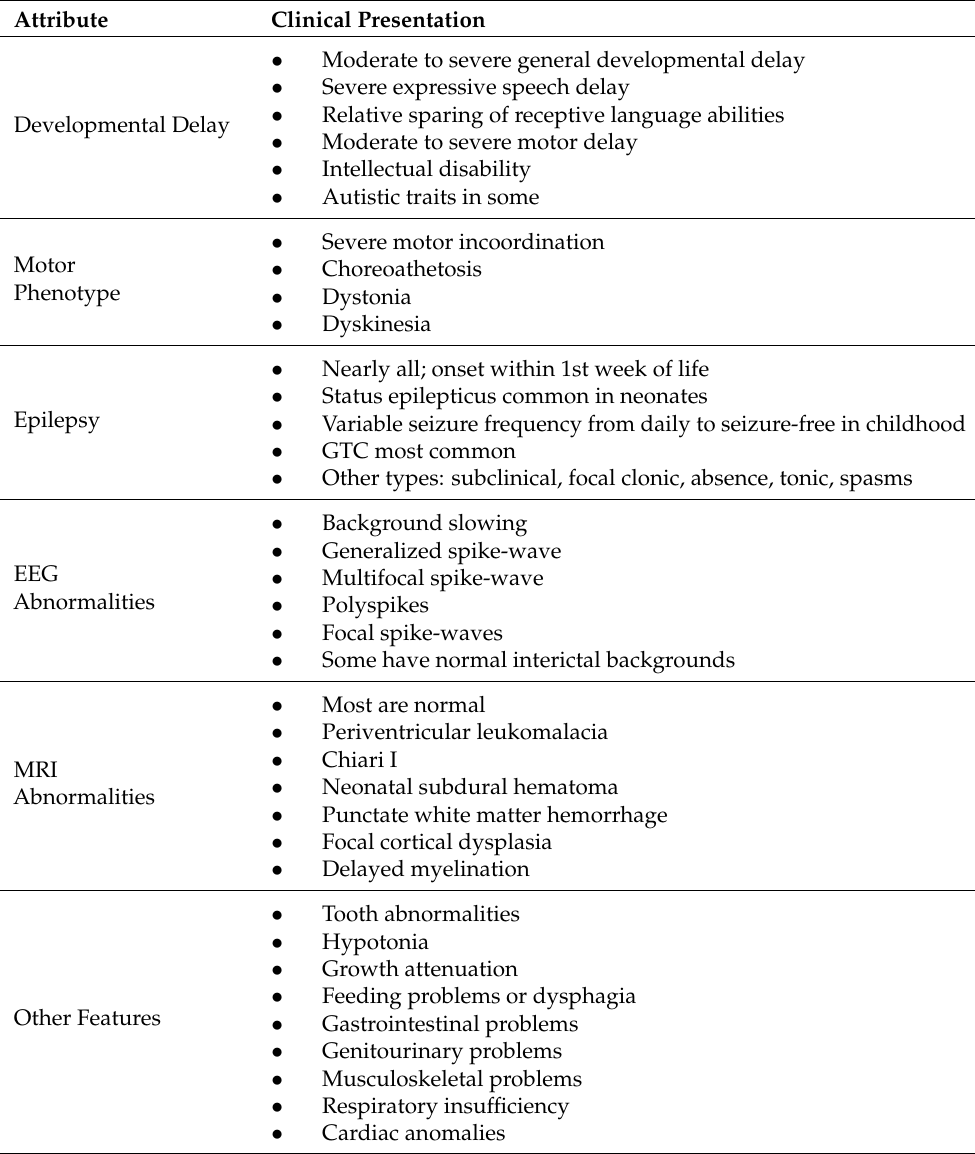
Table 1. SLC13A5 deficiency disorder phenotype—Summary of the phenotypic spectrum reported in the published literature of cases aged 9-months to 29-years. Developmental disability and epilepsy are the cardinal features of SDD. Language impairment is severe with relative sparing of receptive communication and motor disabilities are prevalent. Epilepsy typically starts in the neonatal period with increased variability of seizure-type, seizure-frequency, and EEG abnormalities throughout life. Brain imaging is largely